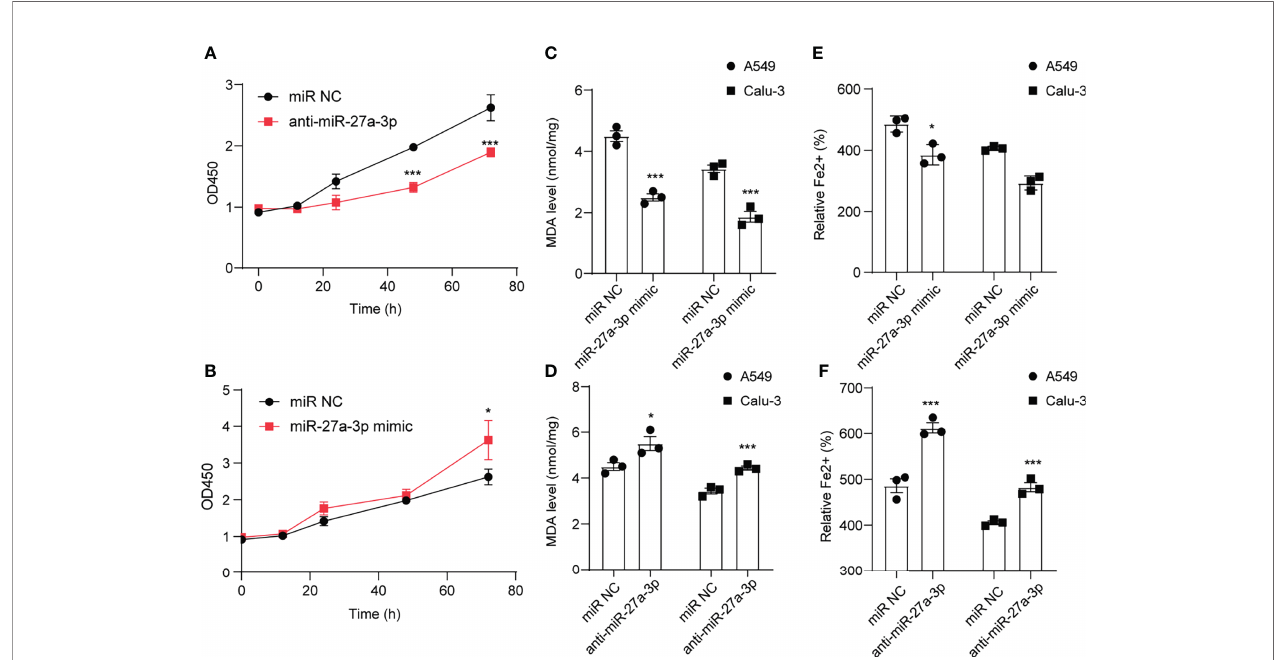
FIGURE 5 | miR-27a-3p regulates erastin induced ferroptosis in NSCLC cells. The in fl uence of miR-27a-3p on erastin induced ferroptosis on A549 and Calu-3 cells. Cell viability (A, B) , MDA level (C, D) , Fe 2+ accumulation (E, F) were determined after miR-27a-3p mimic and anti-miR-27a-3p transfection. *P < 0.05 and ***P < 0.001